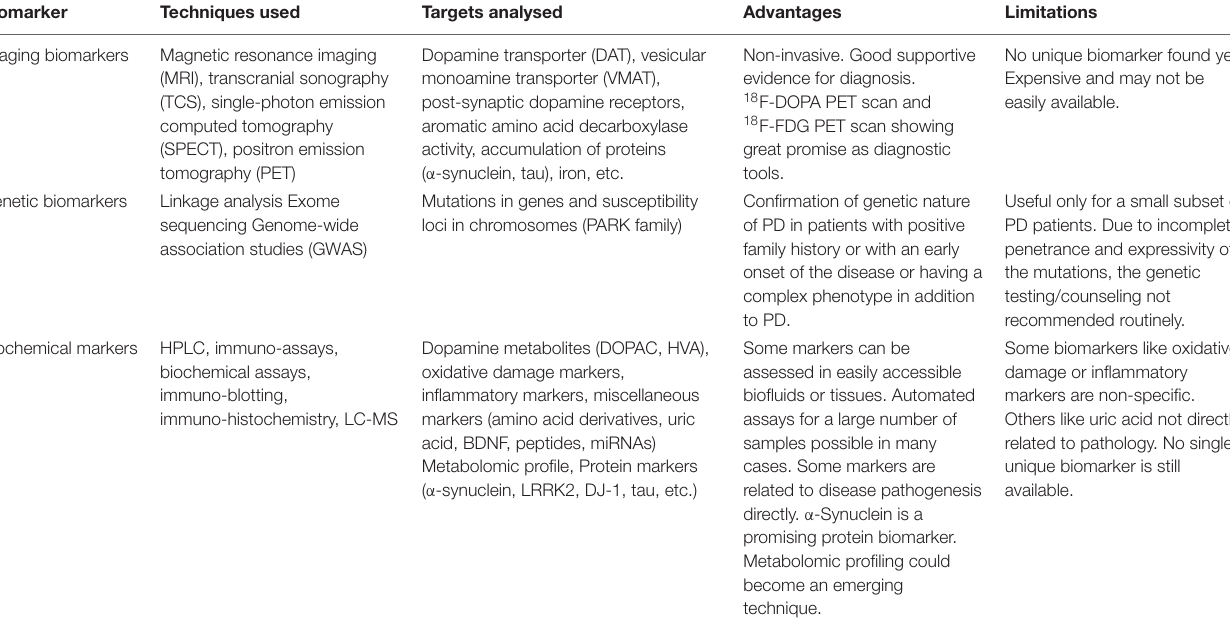
TABLE 1 | Biomarkers in Parkinson’s disease